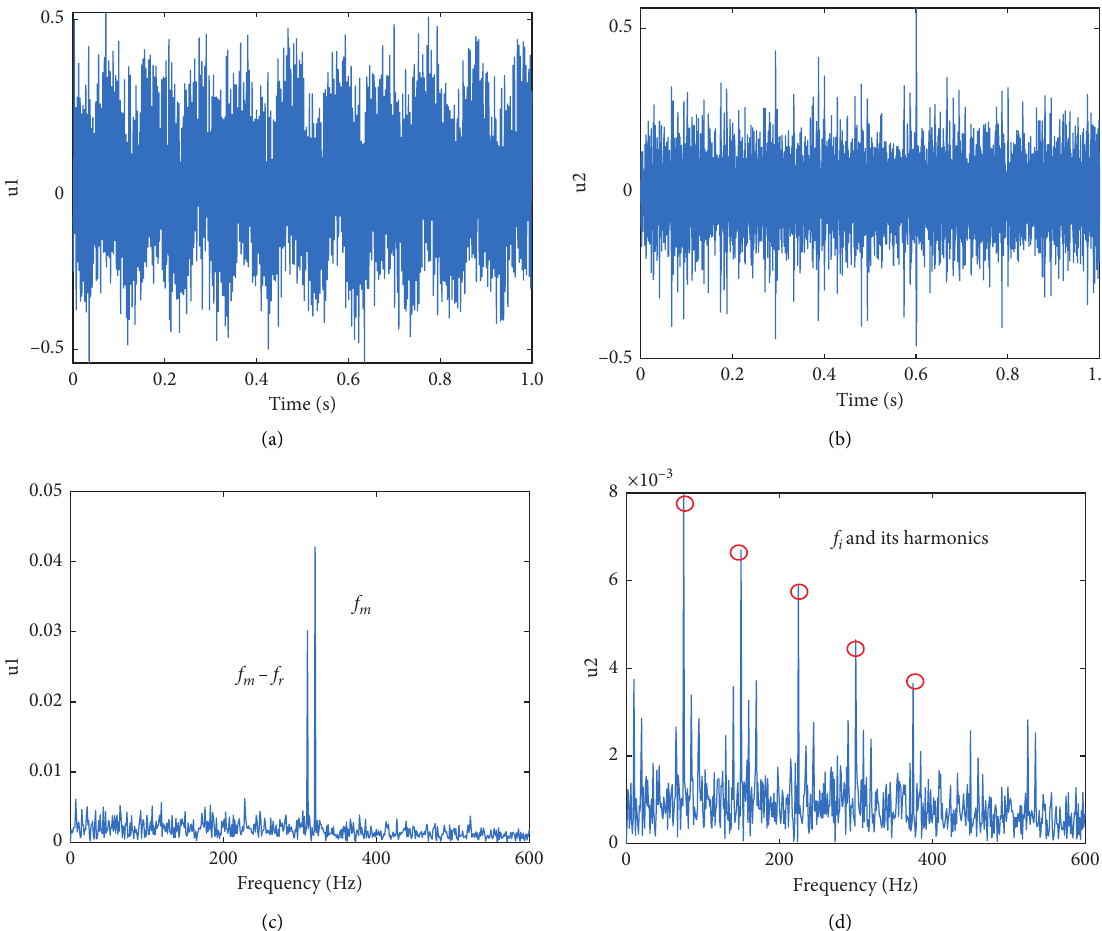
Figure 16: Simulated signals of case 2: signal processing results based on PAVMD, (a, b) time-domain waveform of each mode and (c, d) the corresponding squared envelope spectrum.